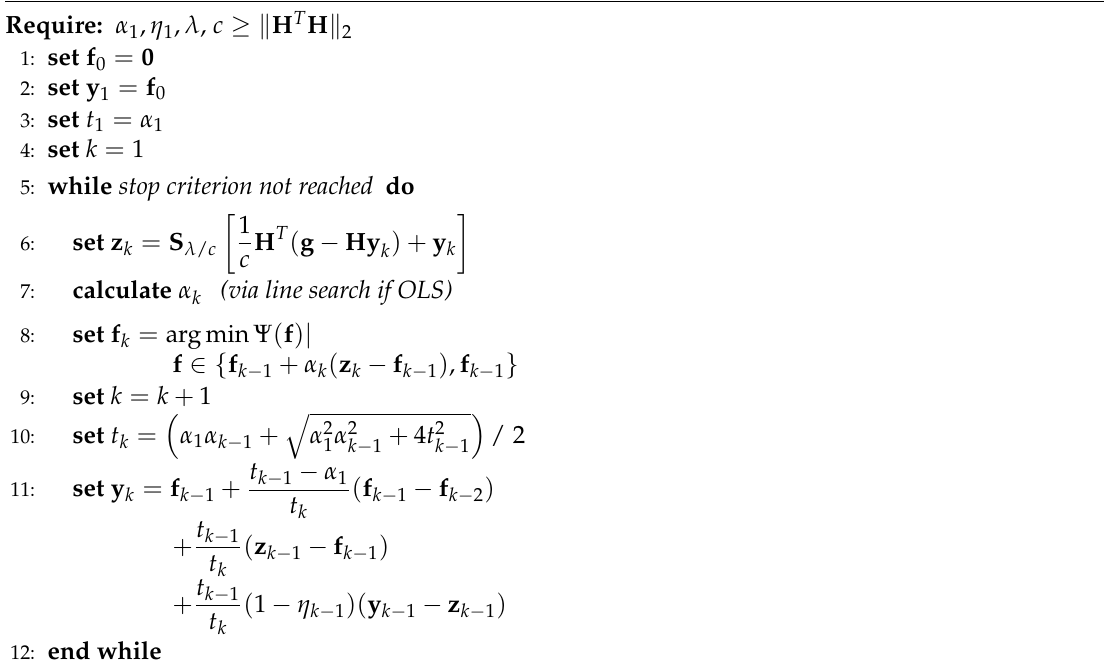
Algorithm 3 Over-Relaxation of Monotone Fast Iterative Shrinkage-Thresholding Algorithm (OMFISTA)